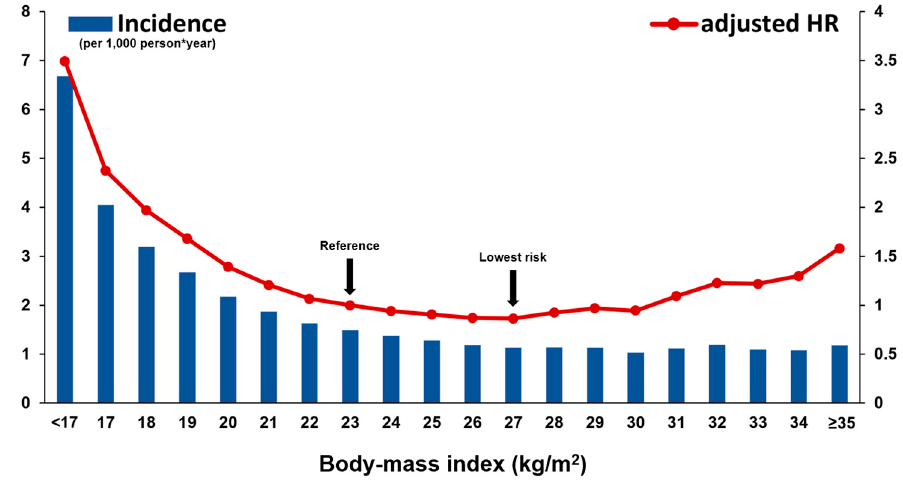
Figure 2. Risk of SCD according to BMI value. The raw incidence of SCD was higher in diabetic patients with low BMI. In the multivariate model, the risk of SCD and BMI showed a U-curve association; the risk was significantly higher in patients with low BMI than high BMI. The multivariate model is adjusted for age, sex, income level, smoking history, alcohol consumption, regular physical activity, hypertension, dyslipidemia, fasting glucose, duration of DM, use of insulin, and number of oral antidiabetic medications. HR: hazard ratio; SCD: sudden cardiac